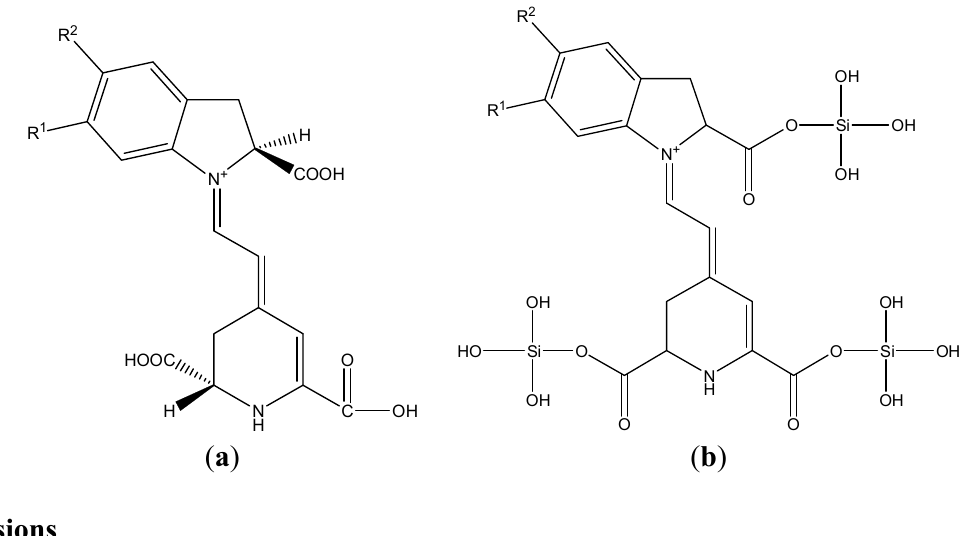
Figure 8. ( a ) Betalain molecule where R=OH was used for the chemical calculations approximation and ( b ) Modified simplified betalain molecule where R 2 = R 1 = OH was used for the chemical calculation